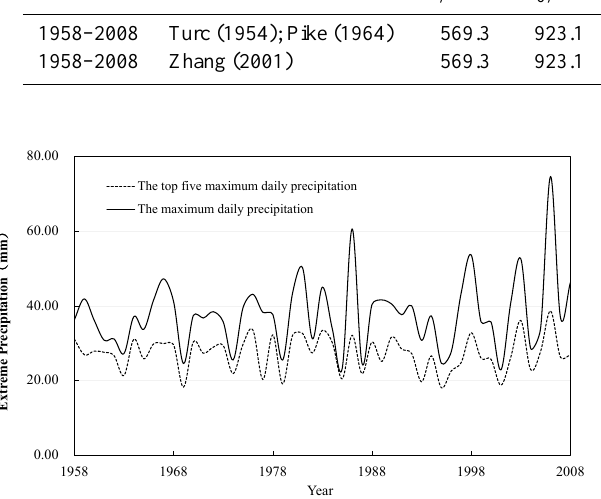
Table 3. Results of the improved climate elasticity method. Period